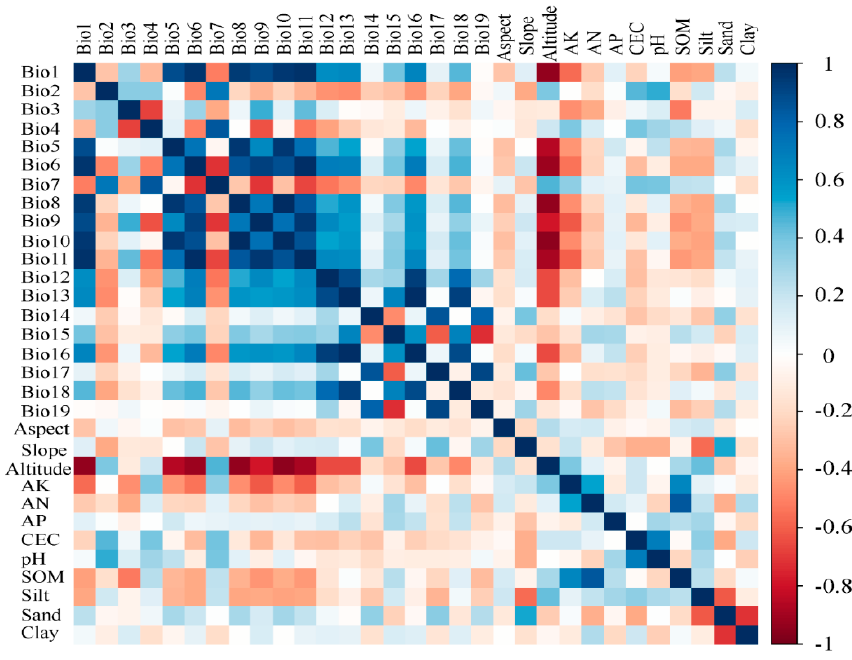
Figure 2. Pearson correlation